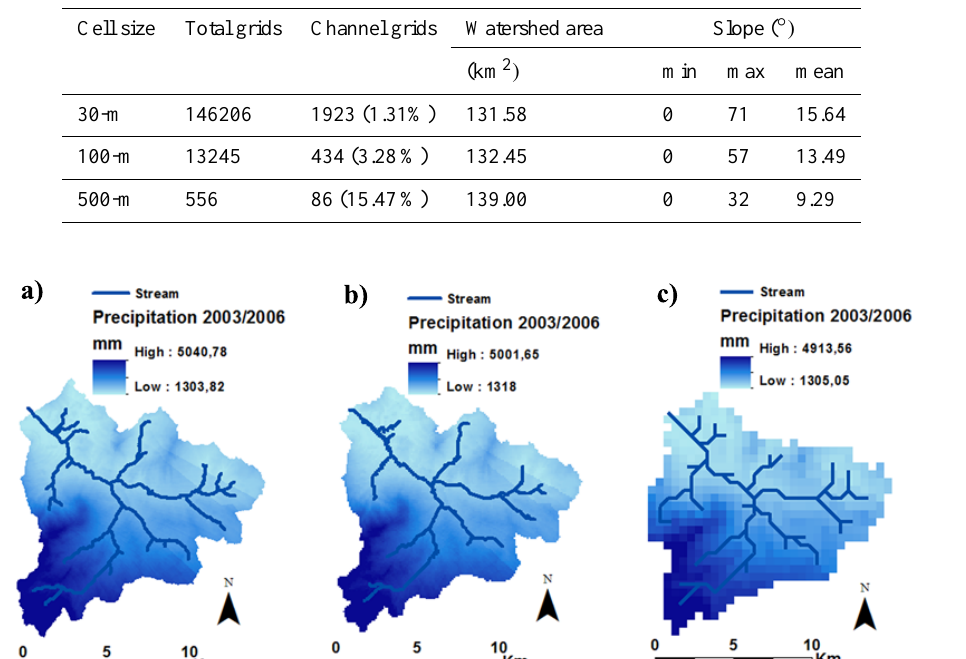
Table 1. Total number of grids, channel grids (absolute value and percentage), watershed area and its variation with increasing cell size, and the calculated mean slope and extremes at 30-m, 100-m, and 500-m cell size.